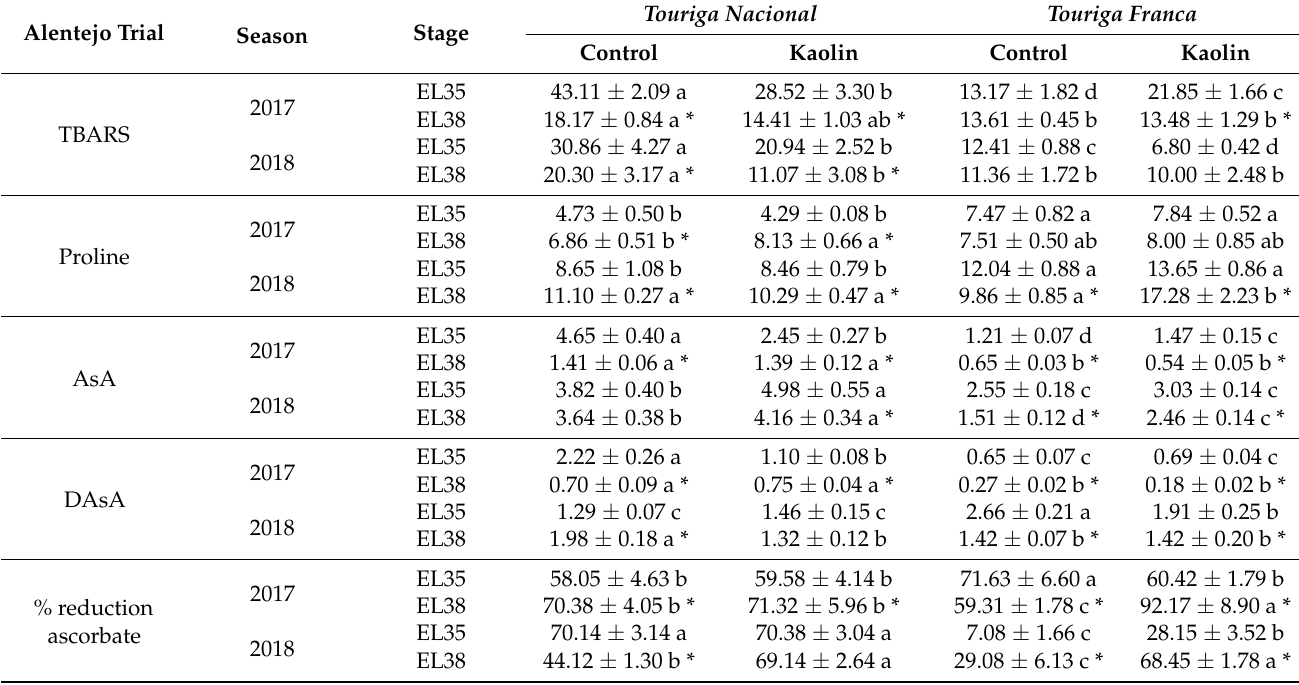
Data are mean ± SD ( n = 6). Different lower case letters represent significant differences between treatments and varieties within each developmental stage (EL35 and EL38), and sampling year. The asterisks (*) indicate significant differences ( p < 0.05) between developmental stages (EL35 vs. EL38) within each variety, treatment, and sampling